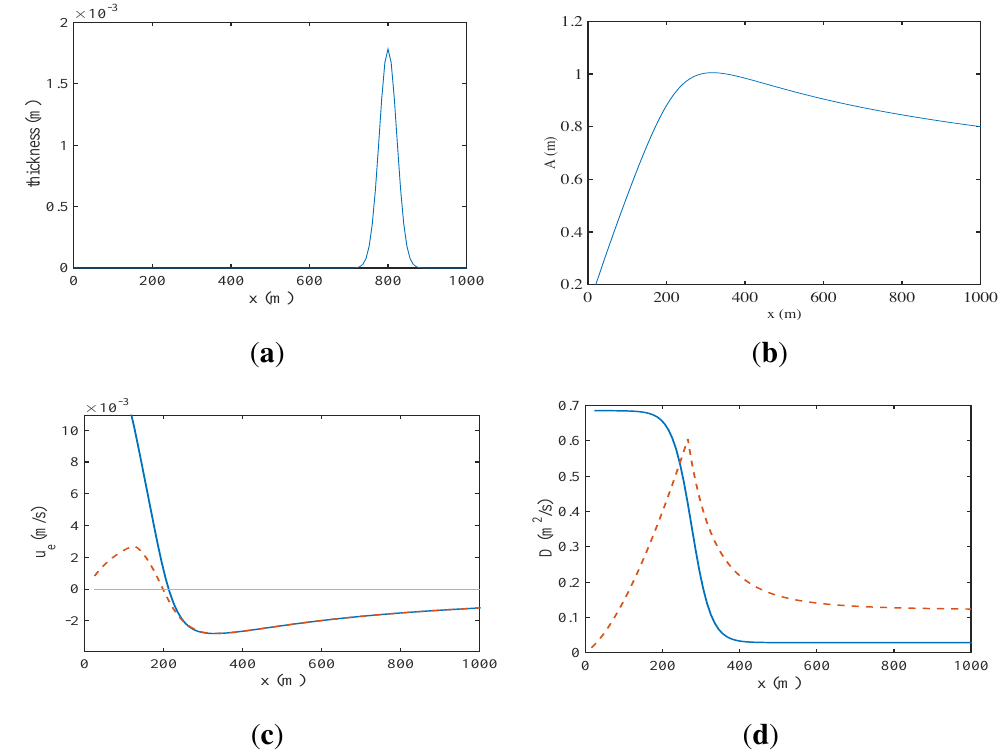
Figure 6. ( a ) The initial pulse s ( x, 0) . S ( x, 0) = 0 ; ( b ) Wave amplitude A ( x ) ; ( c ) Effective ( x ) , using (Equation (43) (solid) and Equation (36) (dashed)); ( d ) Comparison of velocity u e the diffusion models, Equation (43) (solid) and Equation (36)